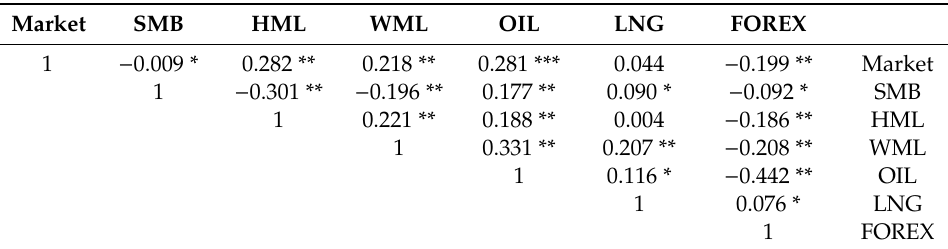
Table 3. Correlation Matrix for Risk